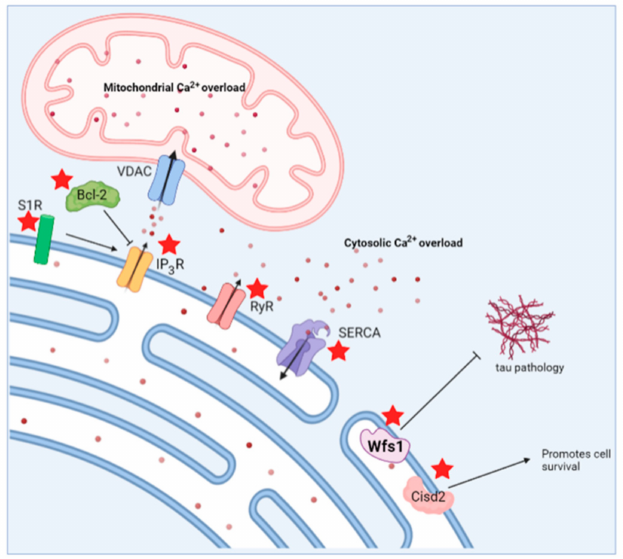
Figure 6. Schematic overview indicating potential therapeutic strategies to target both Alzheimer’s disease and Wolfram syndrome. Possible therapeutic targets are indicated by a red asterisk. S1R, sigma 1 receptor; Bcl-2, B-cell lymphoma 2; IP 3 R, inositol trisphosphate receptor; RyR, ryanodine receptor; SERCA, sarco/endoplasmic reticulum ATPase; VDAC, voltage-dependent anion channel; Wfs1,